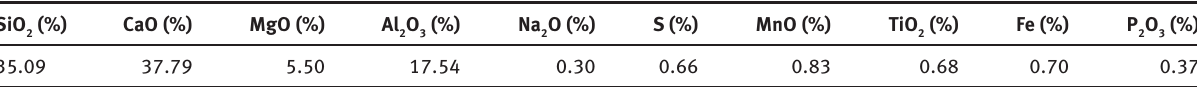
Table 6: Chemical composition of GBFS.